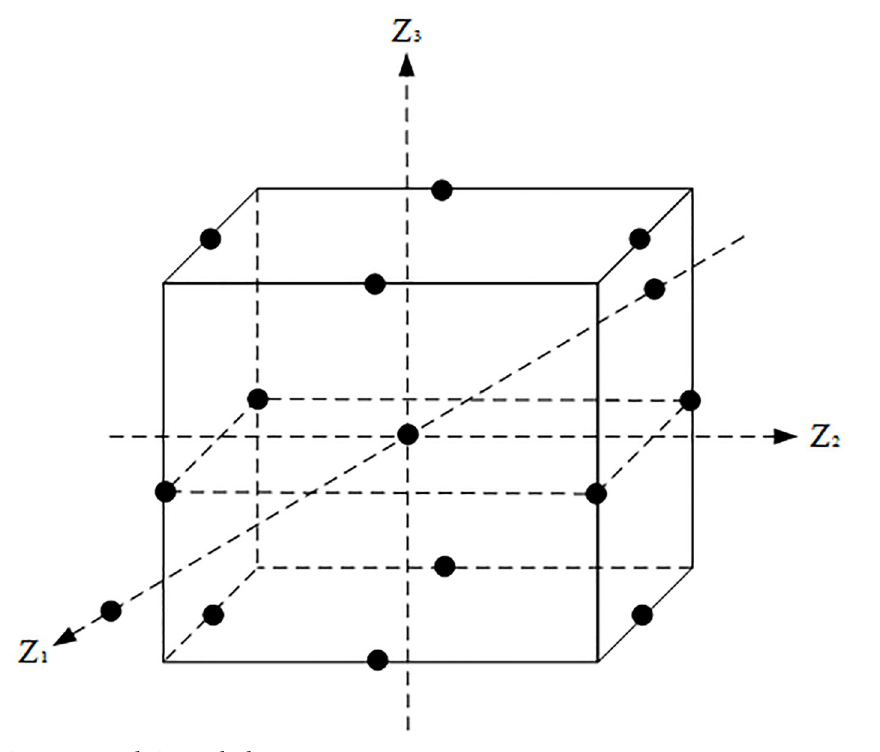
Fig 9. BBD test design method.